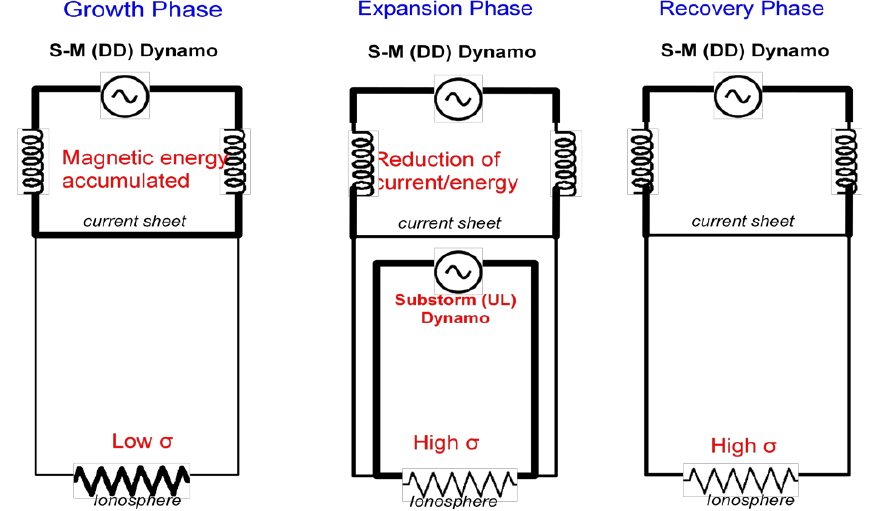
15 Fig. 5. The conceptual circuits for the three phases of auroral